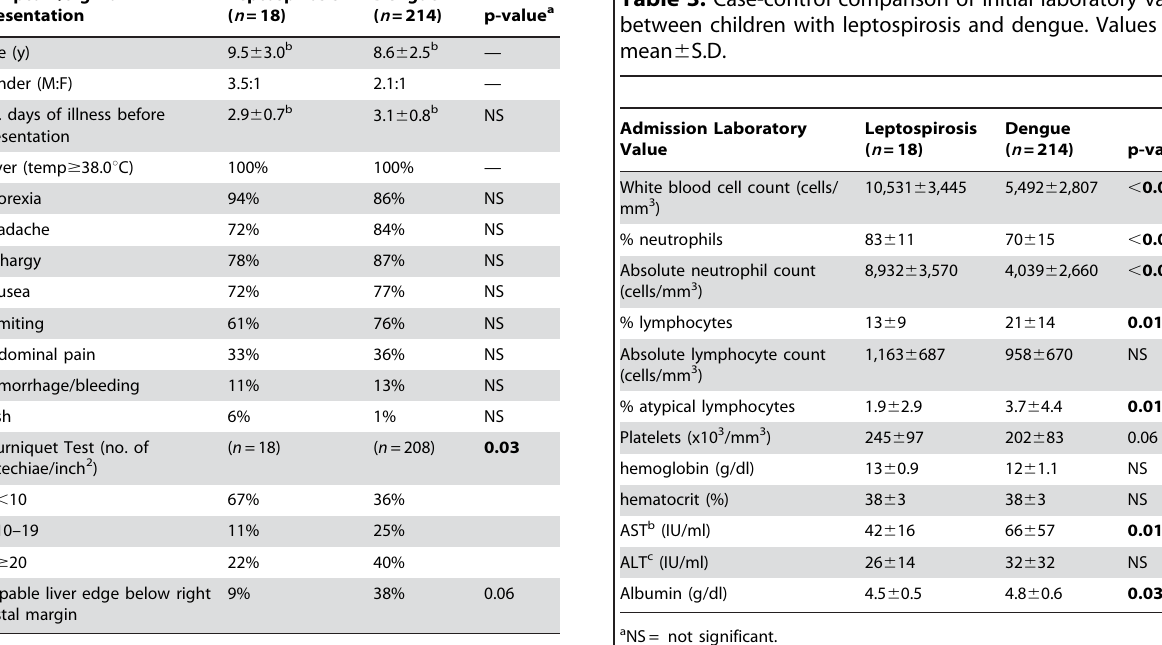
c ALT= alanine aminotransferase.